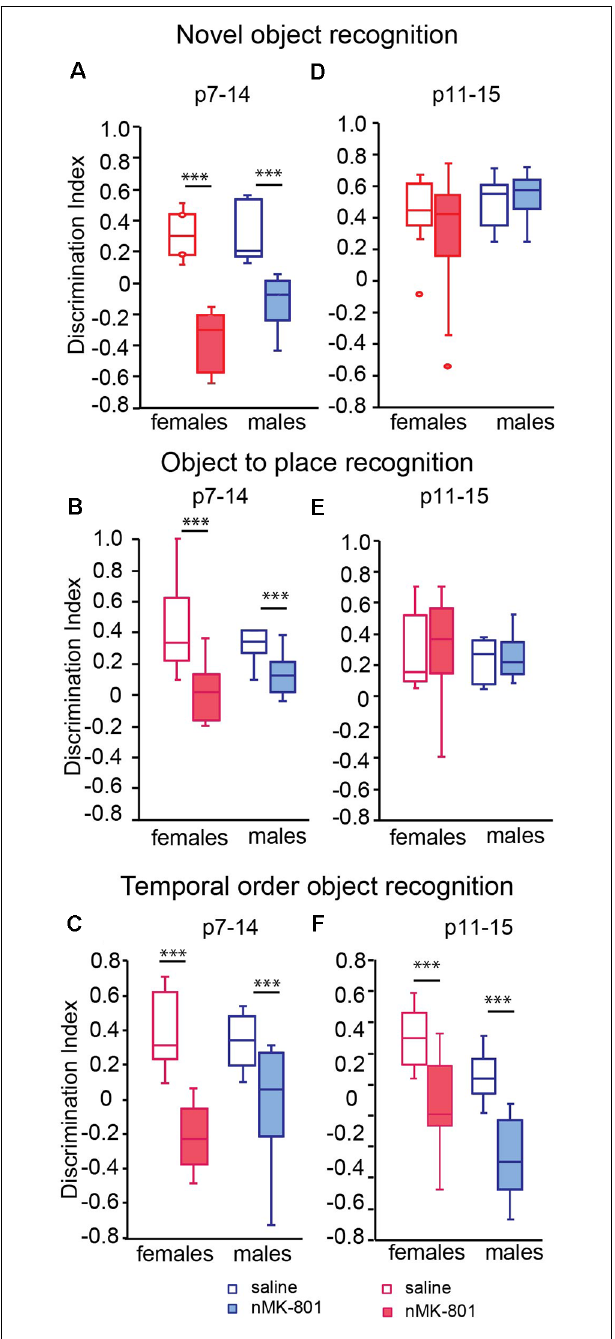
FIGURE 2 | Effects of neonatal treatment with MK-801 at p7–14 ( n = 15) and p11–15 ( n = 15) on the novel object, object to place, and temporal order object recognition (TOR; n = 13 for each saline-treated group). Graphs showing the discrimination index in the novel object recognition (A,D) , the object to place (B,E) , and the TOR (C,F) for adult mice neonatally treated with MK-801 during p7–14 (A–C) and p11–15 (D–F) . Open bars represent saline-treated mice, while colored bars represent the nMK-801-treated mice. (A) In the novel object recognition test, there was a significant effect of nMK-801 (p7–14) treatment ( F (1,26) = 77.621, p < 0.001), but not effect of sex ( F (1,26) = 3.466, p = 0.075) or sex ∗ treatment interaction ( F (1,26) =